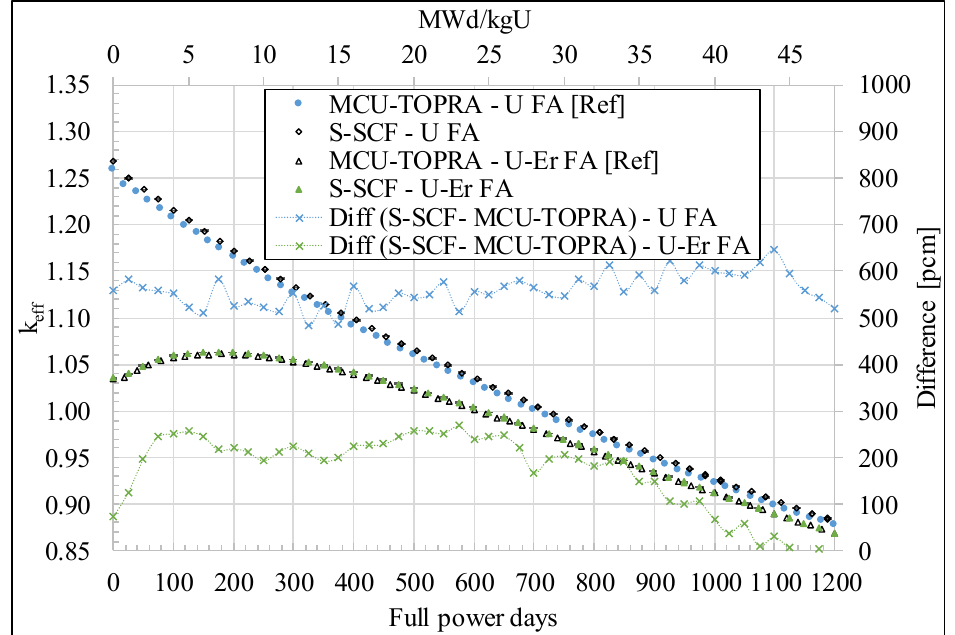
Figure 3 Comparison of effective multiplication factors for U and U-Er fuels with reported